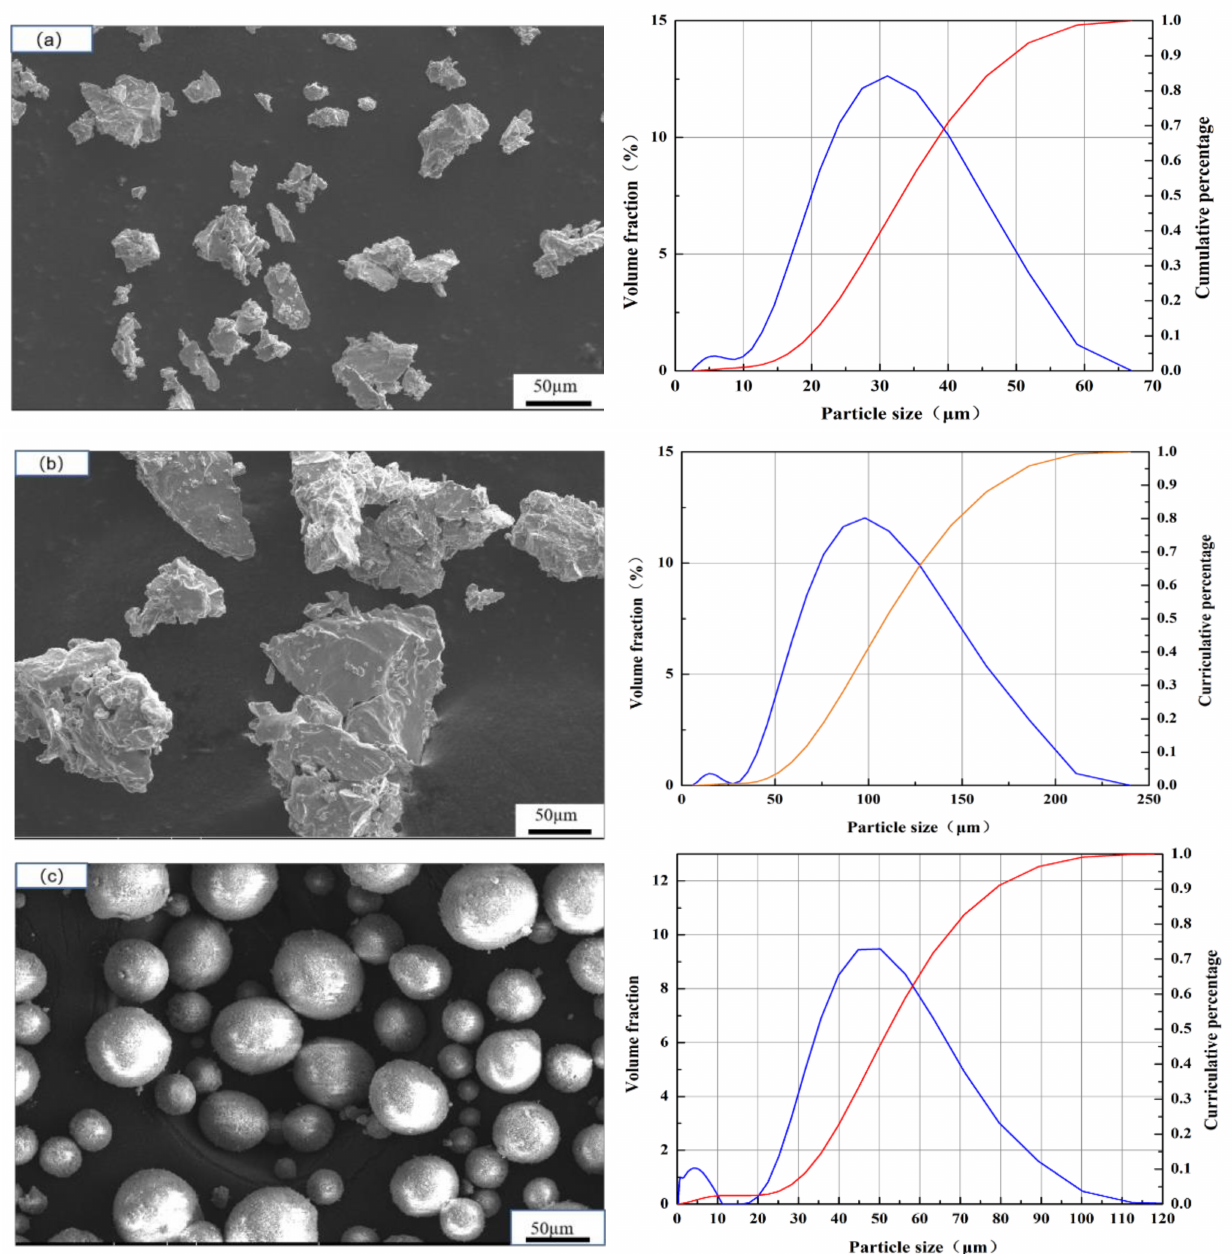
Figure 1. Size and morphology of the feedstocks: ( a ) spongy titanium powder with fine size; ( b ) spongy titanium powder with coarse size; ( c ) spherical hydroxyapatite